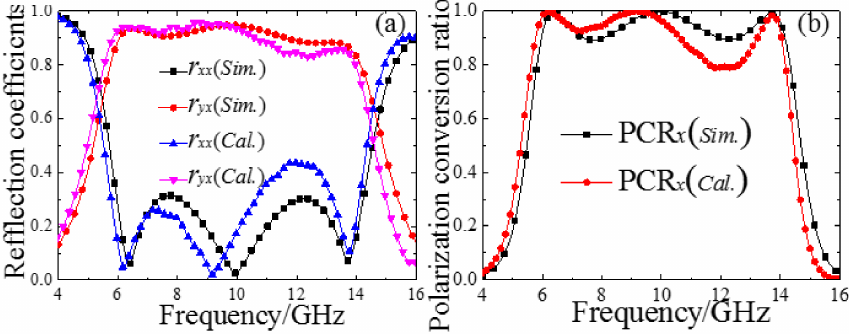
Figure 3. Simulated, calculated ( a ) reflection coefficients and ( b ) PCRs of the designed